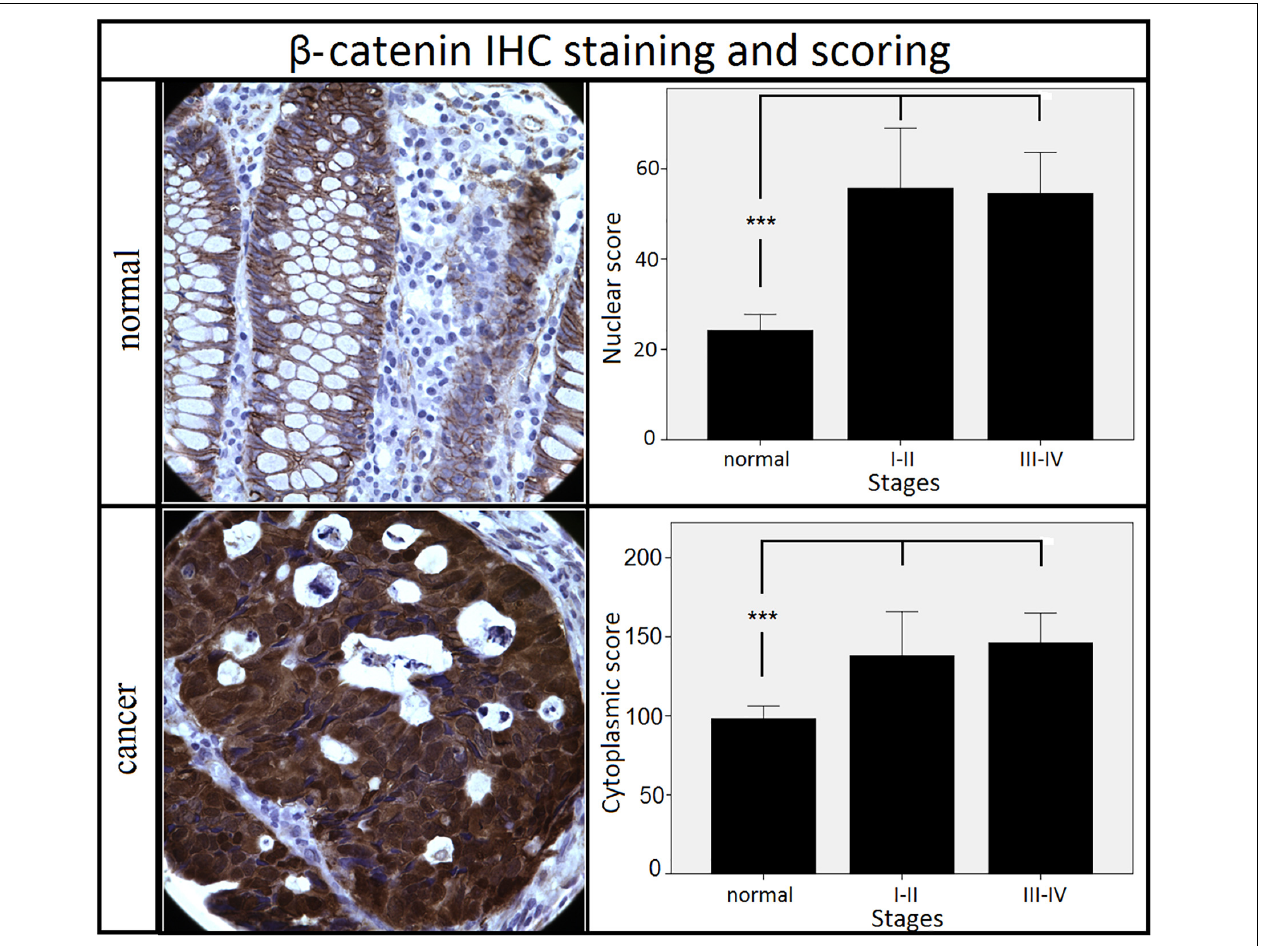
FIGURE 3 | Staining patterns and scoring results for β -catenin. Nuclear and cytoplasmic staining of β -catenin increased in cancer tissues when compared to the adjacent mucosa. No difference was observed between different stages of cancer. *** p < 0.001 (Kruskal–Wallis test followed by post hoc Dunn-Bonferroni test for pair-wise comparisons). Error bars: ± 2 SE. Sample numbers: normal = 32, stages I–II = 11, stages III–IV = 21. Magnification: 630 ×